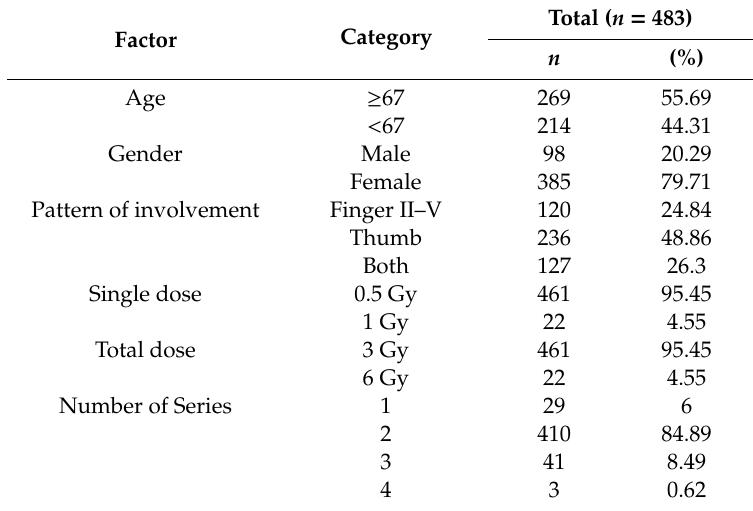
Table 2. Patient